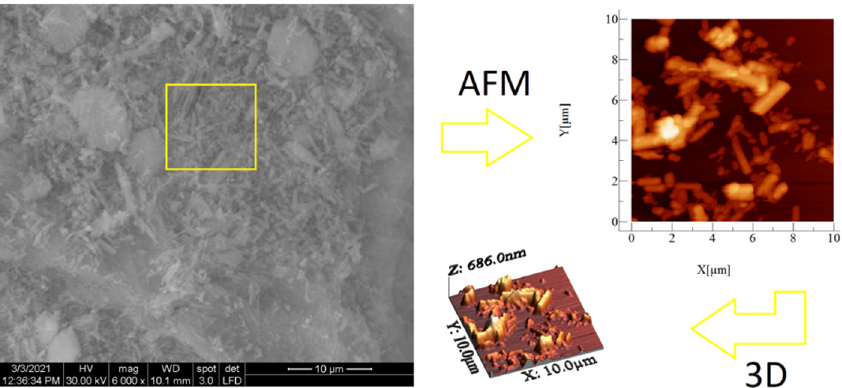
Figure 7. SEM and AFM images at different scales for the S HighTP sample. The yellow square on the SEM image it’s indicative of the surface area analyzed by AFM (image at right).